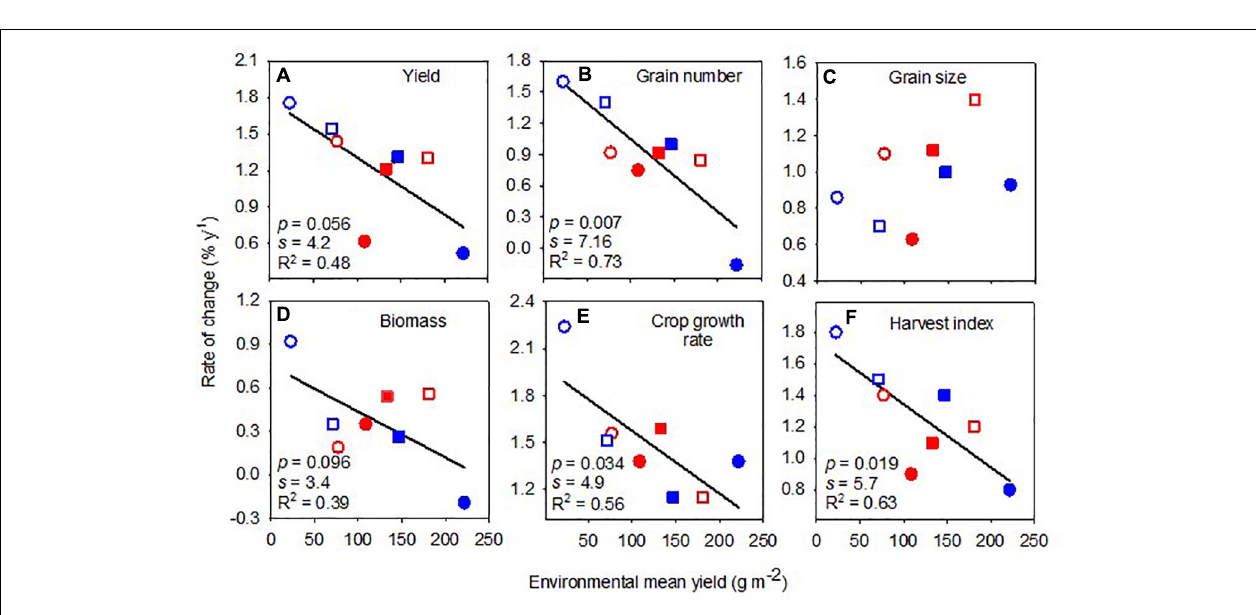
FIGURE 3 | Rate of change of the ratio: time between pod emergence and maturity/time to maturity against environmental mean of the ratio (A) and environmental mean yield (B) . Lines are least-square regressions. Rates are relative to the newest variety. Symbols are: blue (2018), red (2019), circles (early sowing), square (late sowing), open (rainfed), closed (irrigated).